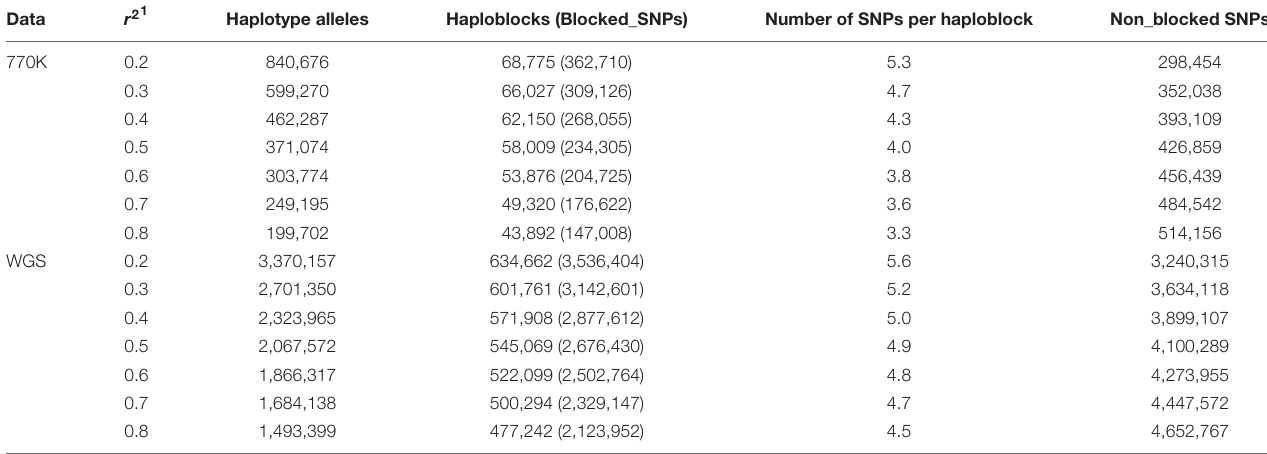
TABLE 3 | Total number of haplotype alleles, haploblocks, and the non_blocked SNPs from the 770K array and sequence data.